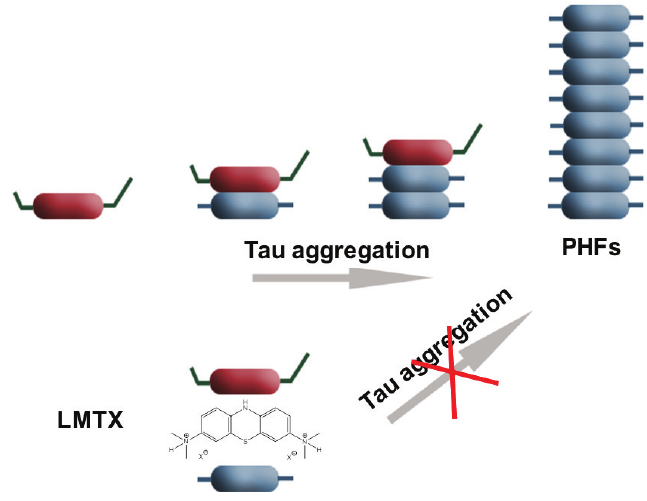
Figure 8. Diagram of tau aggregation inhibitor LMTX (leucomethylthioninium with a suitable counterion), and its presumed mode of action (inhibition of tau aggregation).